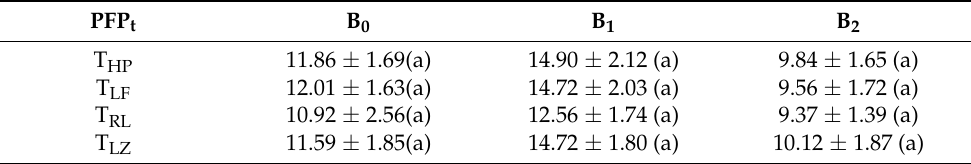
Table 3. Partial factor productivity from applied nitrogen of topdressing (PFP t